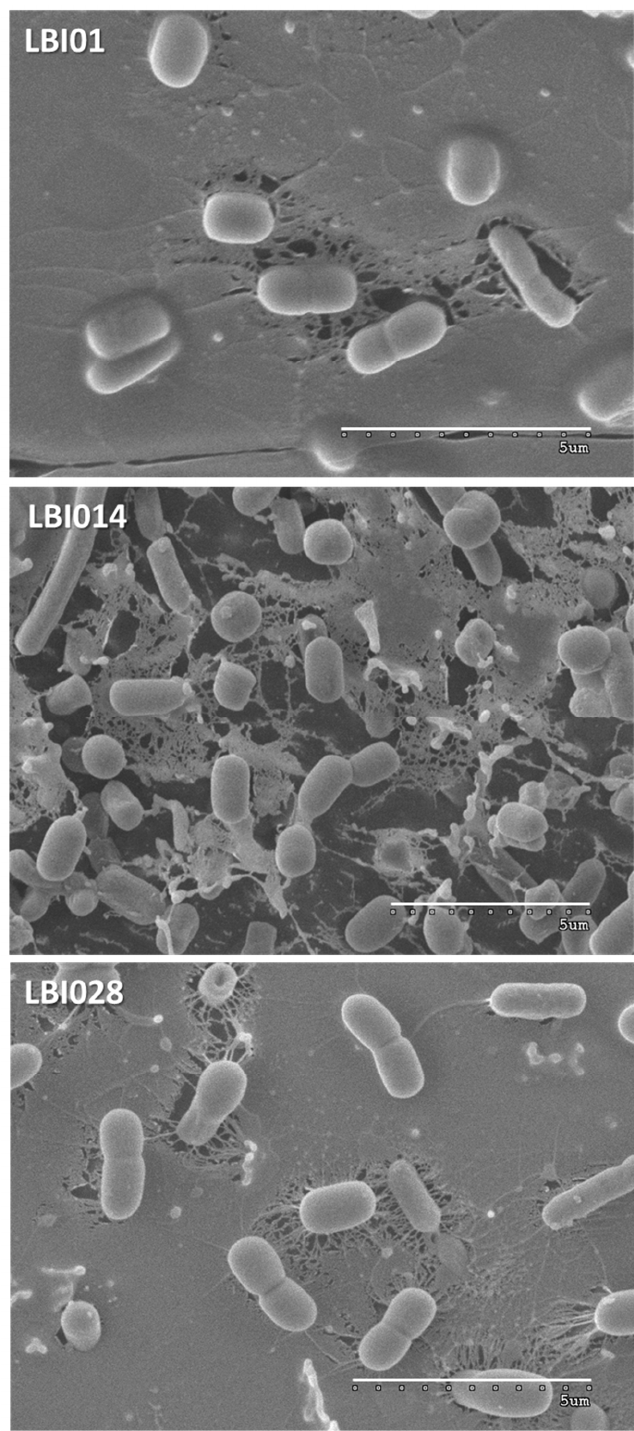
Figure 1. Cryo-scanning electron microscopy (cryo-SEM) of bacterial biomass collected from 24 h MRS broth cultures of the exopolysaccharide (EPS)-producing L. plantarum strains LBIO1, LBIO14 and LBIO28. The EPSs are the matrix surrounding the bacterial surface. Bar 5 µ